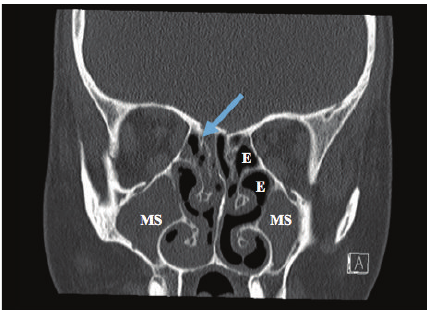
Figure 2: CT scan of the paranasal sinuses showing complete opacification of the maxillary sinuses (MS) bilaterally and some of the ethmoid air cells (arrow) including the sphenoid sinuses. There is also obliteration of the osteomeatal complexes